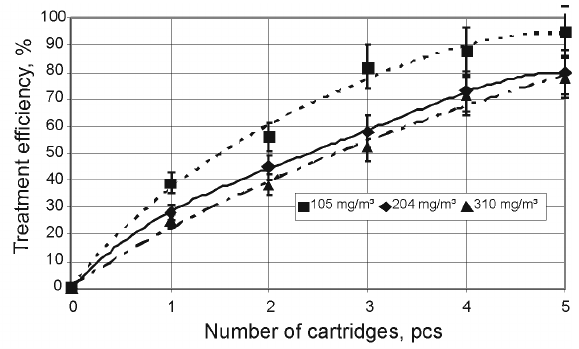
Fig. 6. Dependence biofilter treatment efficiency on the number of cartridges when the original concentration of butanol is varying